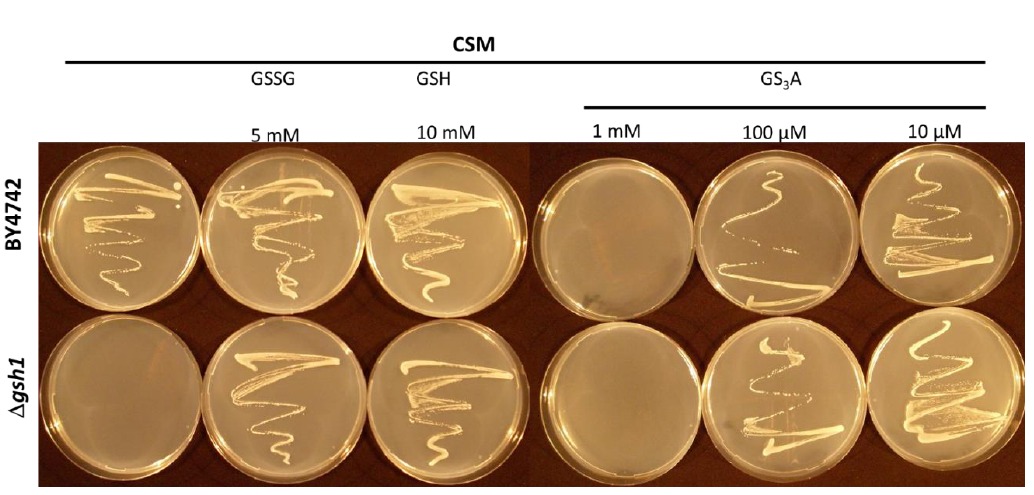
Figure 6. Growth of the wildtype diploid BY4742 yeast strain compared with the Δgsh1 mutant on complete synthetic mixture (CSM) and CSM supplemented with 10 mM glutathione (GSH), 5 mM glutathione disulfide (GSSG), or 10 mM S -allylmercaptoglutathione (GSSA). A 100 µL aliquot of a logarithmically growing yeast culture adjusted to OD 600 = 0.2 (OD = optical density) was spread onto the surface of each plate with an inoculation loop spatula.